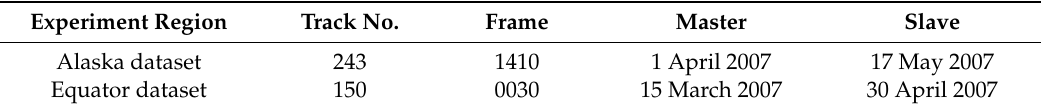
Table 1. Dataset information of application